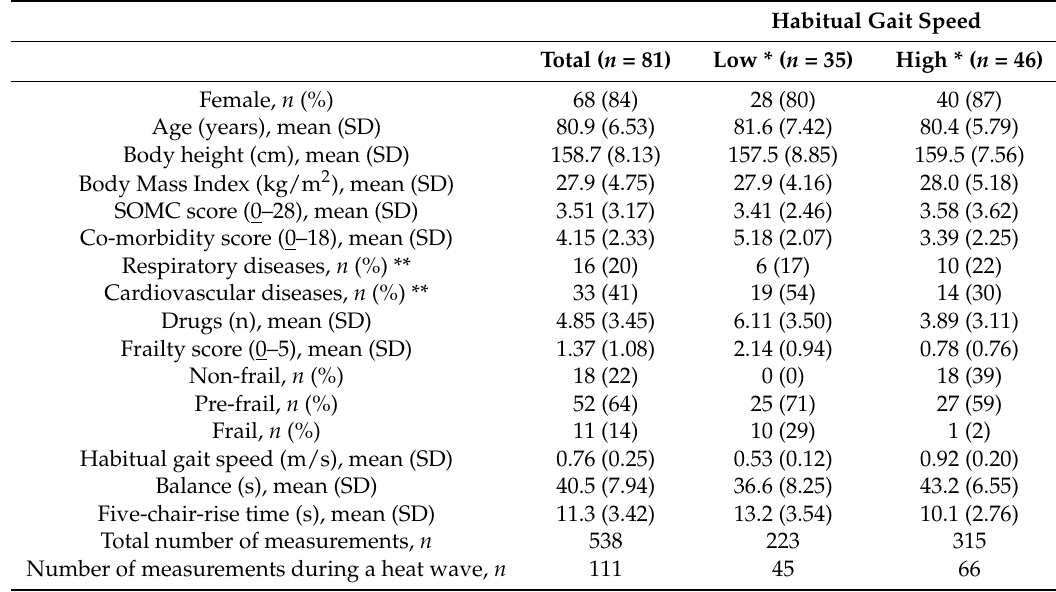
Table 1. Baseline characteristics of all